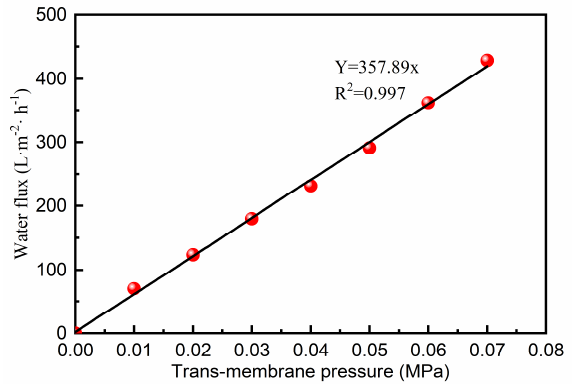
Figure 4. Effect of trans-membrane differential pressure on pure water flux.